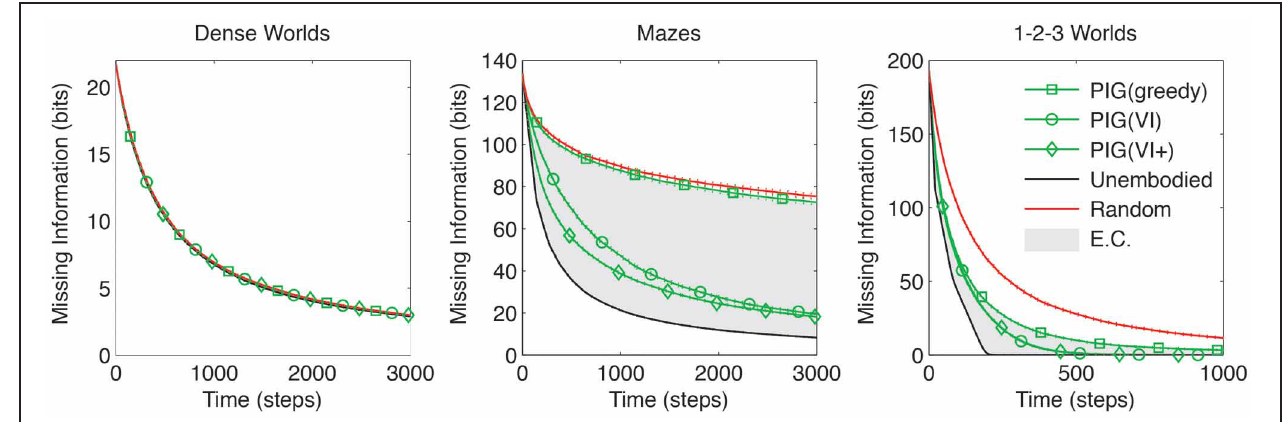
FIGURE 4 | Coordinating exploration using predicted information gain. The average missing information is plotted over exploration time for greedy and value-iterated (VI) maximization of PIG. The